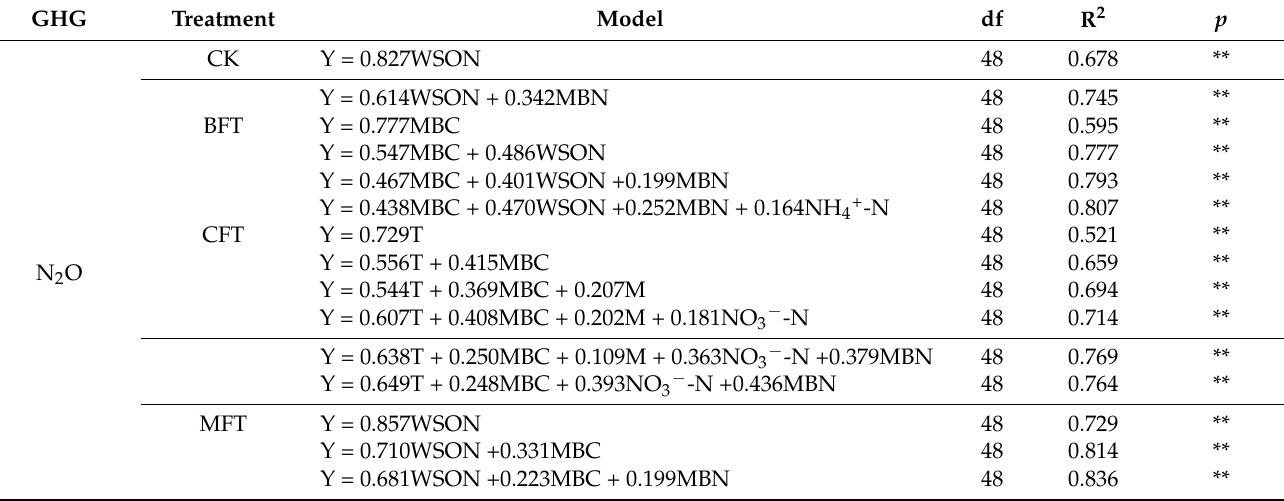
Table 2. Model for stepwise regression analysis between N 2 O flux ( µ g m − 2 h − 1 ) and soil temperature (T, ◦ C), soil moisture (M, g kg − 1 ), microbial biomass C (MBC, mg kg − 1 ), water-soluble organic C (WSOC, mg kg − 1 ), microbial biomass N (MBN, mg kg − 1 ), water-soluble organic N (WSON, mg kg − 1 ), NO 3 − -N, and NH 4+ -N under CK, BFT, CFT, and MFF treatments. (The coefficient in the model is